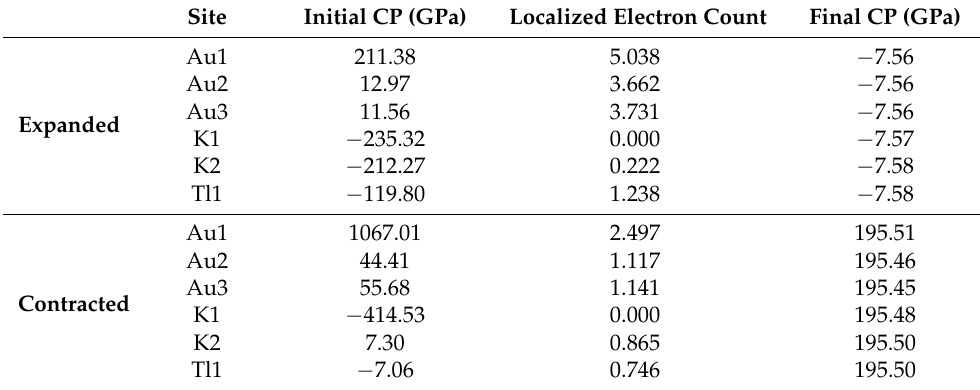
Table 1. Localized electron calibration result for K 3 Au 5 Tl at expanded volume.